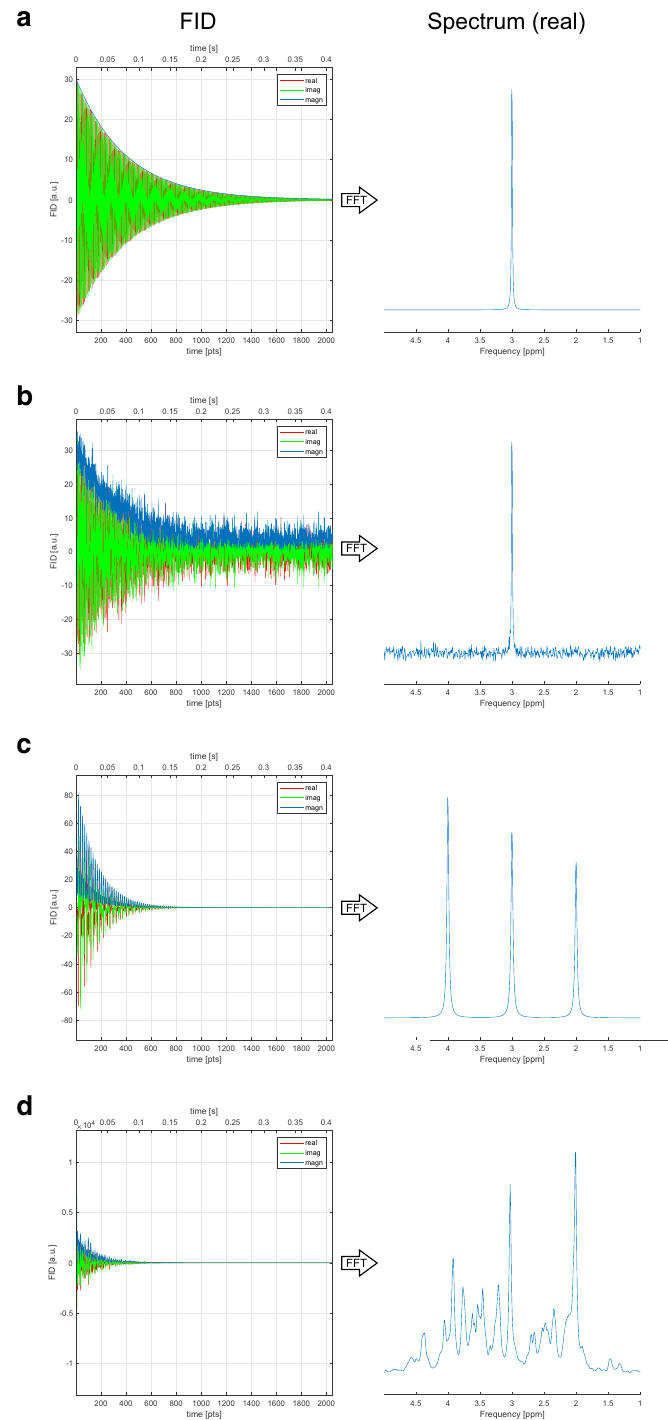
Figure 5. Example generation of singlet and other spectral signals with INSPECTOR. ( a ) Simulated free induction decay (FID) of a singlet [frequency:3 amplitude:30 linewidth:4] with corresponding peak in the frequency domain. The singlets were simulated with Larmor frequency of 298.1 MHz, synthesizer calibrated on 4.65 ppm, bandwidth of 5 kHz and 2048 complex points. ( b ) Adding noise (FID noise = 0.05) to this signal illustrates the concept of signal-to-noise ratio and its impact on MRS data quantification. In this case, the SNR was 62. ( c ) Simulation of multiple singlets ([2 25 10], [3 30 10], [4 35 10]) can help explain different frequencies in the FID and chemical shifts in the frequency domain. ( d ) A synthetic brain spectrum can be generated from readily available metabolite-specific 7 T spectral basis functions incorporated into INSPECTOR to demonstrate the effect of noise on spectral appearance and quantification of spectral signals resembling in vivo